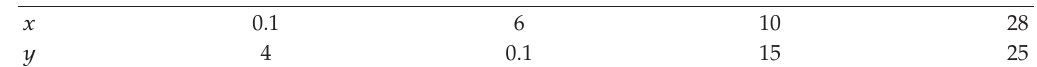
Table 2: A 2D positive data set.